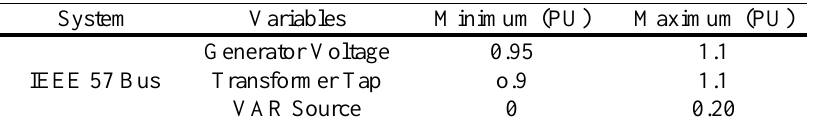
Table 7. Constraints of control variables.